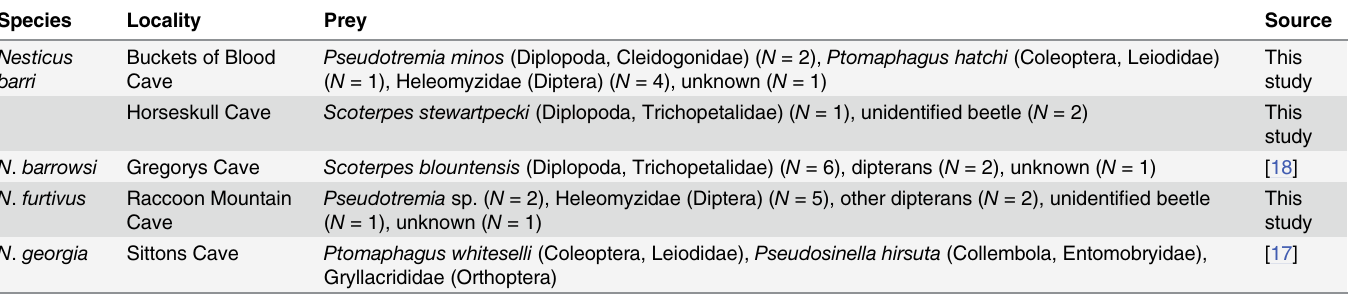
Table 3. Prey observations for troglobiotic Nesticus from the southern